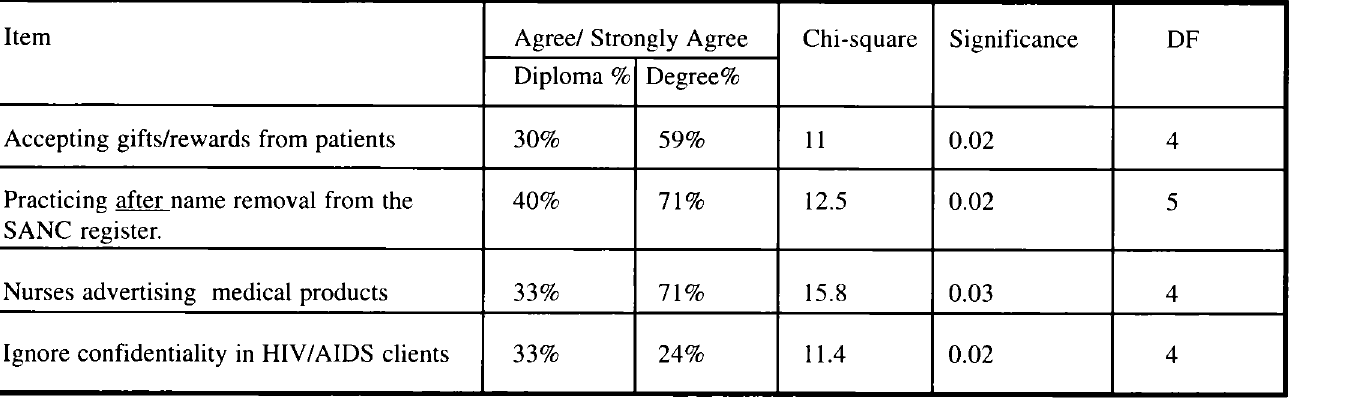
Table 2: Differences in the application of ethics theory to practice